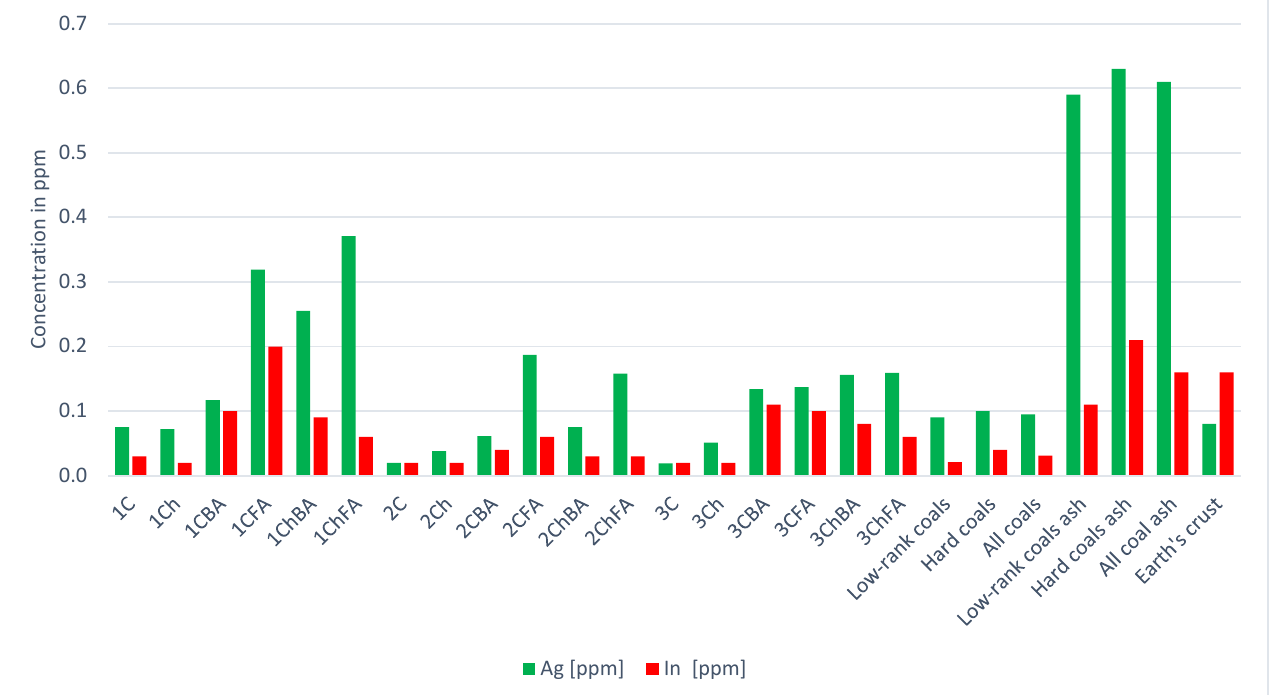
Figure 2. The Ag and In content of coal, char, and ashes and their Clarke values [21]. For example, such elements as bismuth (Bi), chromium (Cr), cuprum (Cu), germanium (Ge), hafnium (Hf), niobium (Nb) tungsten (W), and yttrium (Y) are some of the most sought-after raw materials, as they are widely used in modern technologies. Germanium is one of those elements that can be concentrated in coal deposits [39–41] and in ashes from gasification processes [42,43]. It is also recovered from the high-Ge coal deposits in Inner Mongolia [44] and residues from gasification processes. [45,46]. In recent years it has been shown that world-class Ge deposits result from the interaction of hydrothermal fluids with organic matter in coal seams [41]. Unfortunately, in the tested samples, the Ge concentrations are below the Clarke value for coal and the Earth’s crust (Figure 3). The concentrations of Bi, Hf (Figure 3), W, Zr (Figure 4), Nb (Figure 5), Cr, and Cu (Figure 6) are at similarly low level. As can be seen from literature data and the calculated Clarke values for coal and its ashes [47], the W [41], Zr [48,49], Hf [50,51], Nb [37,52], and Cr [53,54] concentrations in coal may be sufficiently high to justify their recovery. When it comes to Bi, Cu, and Y concentrations in the ash from the combustion of sample 1, they were shown to be above their average Clarke values but at the same time well below the designated Clarke value for coal ash.